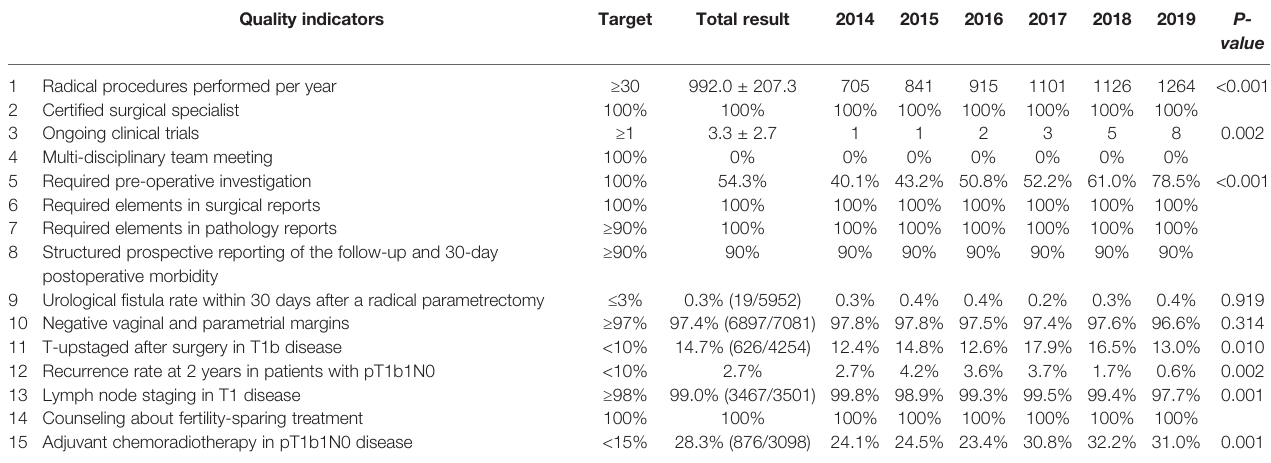
TABLE 2 | Evaluation of the ESGO quality indicators in the hospital. Quality